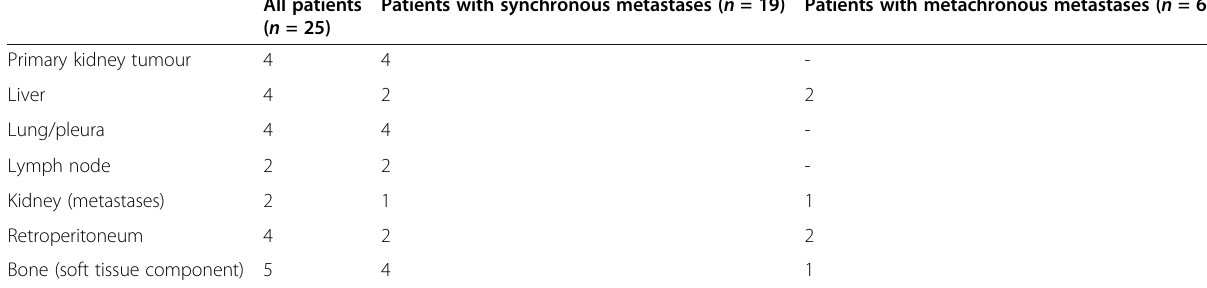
Table 1 Target lesion localisation